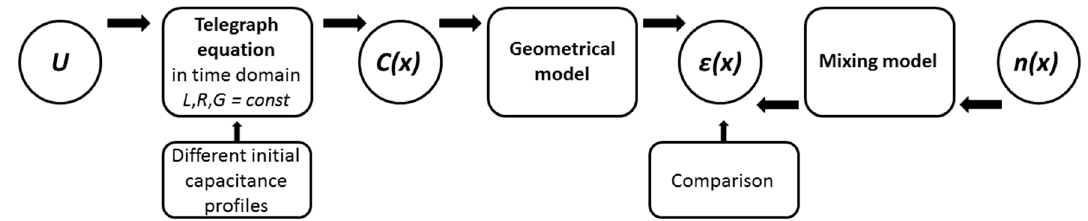
Figure 6. Scheme of the validation of the inversion algorithm.